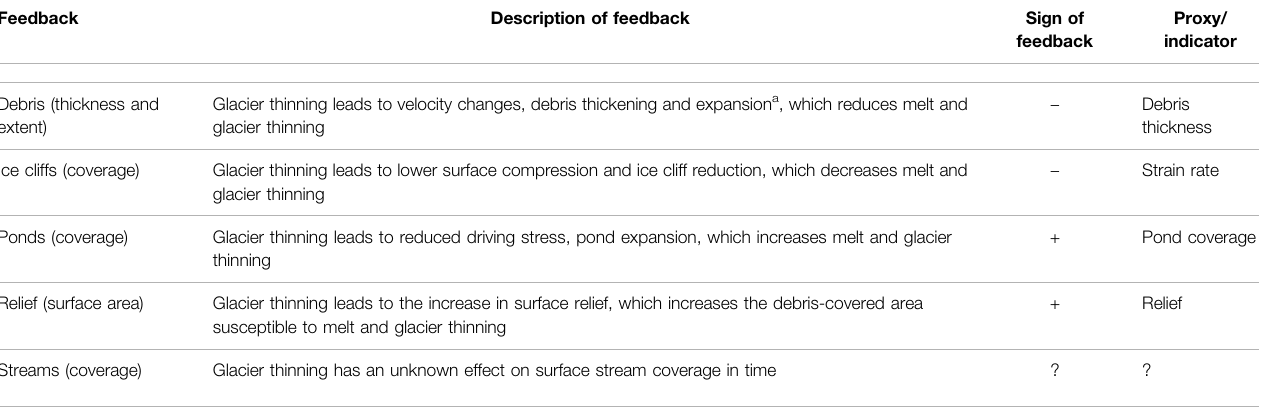
TABLE 1 | Thinning-melt rate feedbacks occurring over multiple decades at Kennicott Glacier.